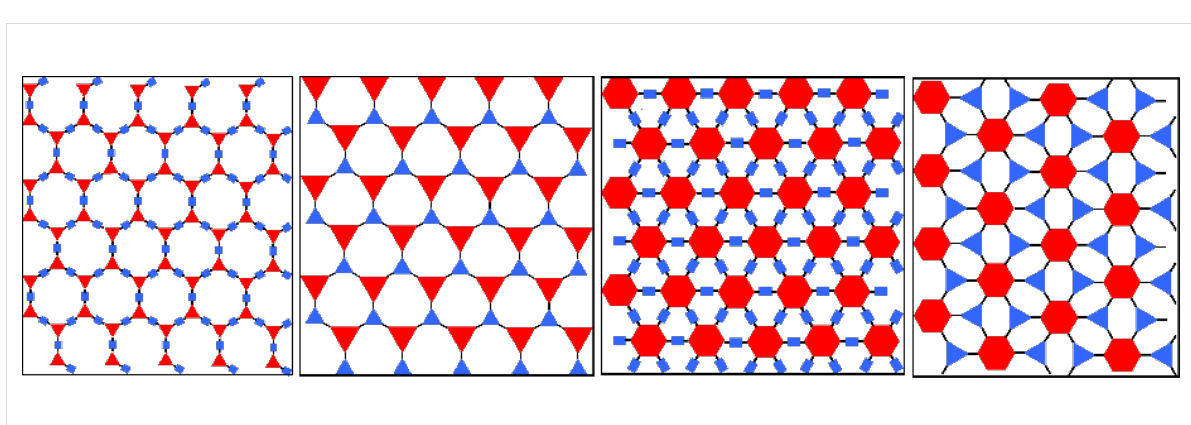
absence of five-membered C 2 O 2 B rings, a zigzag shift leads to staggering in both connector and linker parts. For those made of other connectors, staggering at the connector or linker depends on whether the shift is armchair or zigzag, respectively